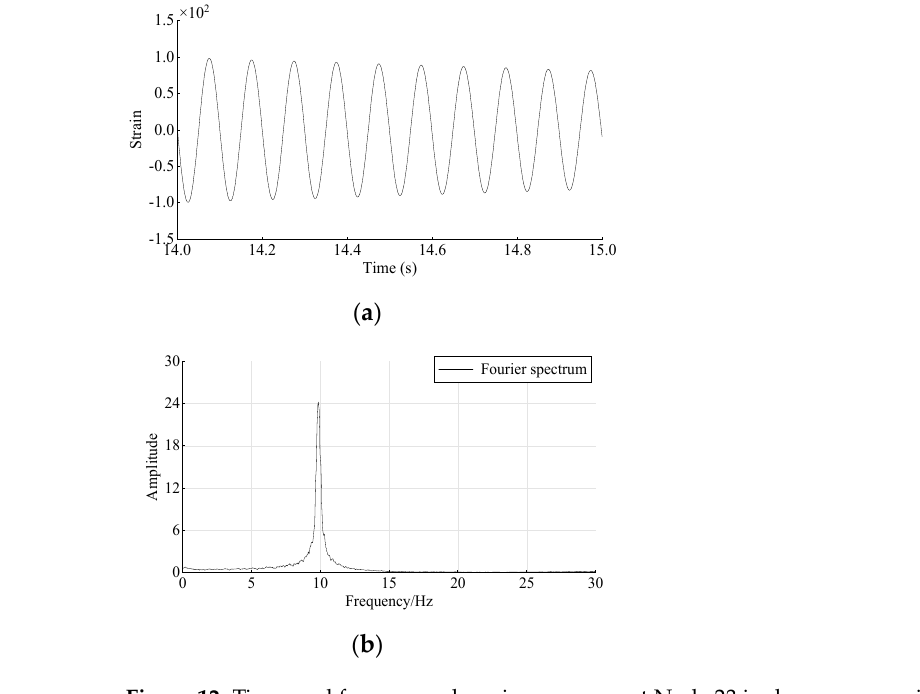
Figure 12. Time- and frequency-domain responses at Node 23 in damage scenario 2: ( a ) response in time domain; ( b ) response in frequency domain.